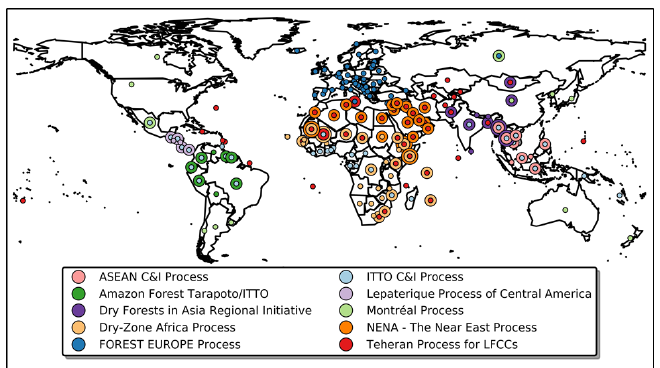
Figure 1. Distribution of the member countries or countries involved in all C&I processes. Total of 171 countries. 52 countries participate in 2 processes. 6 countries participate in 3 processes. Armenia, Azerbaijan, Guinea, Nigeria, North Korea, Paraguay and Uzbekistan do not participate in any regional or international C&I process. ATO/ITTO is above included in ITTO.